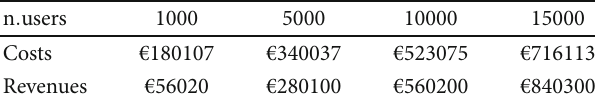
Table 8: CEP costs and revenues per user number —